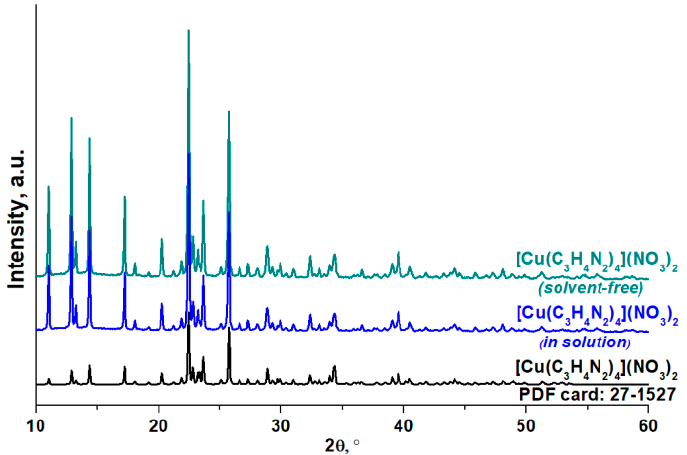
Figure 2. XRD pattern of tetra(imidazole)copper(II) nitrate complex prepared by melting-assisted solvent-free synthesis and in the